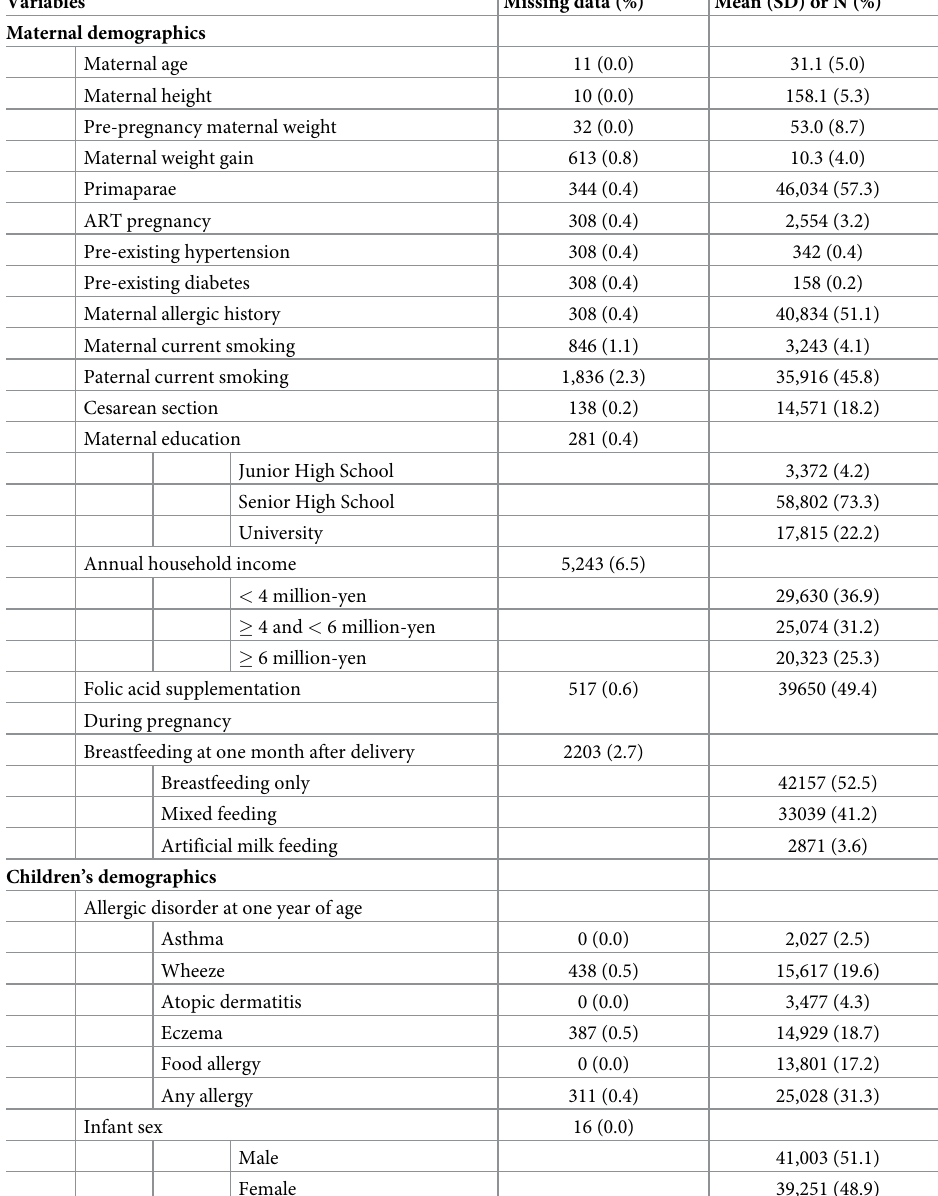
Table 1. Demographic background of the 80,270